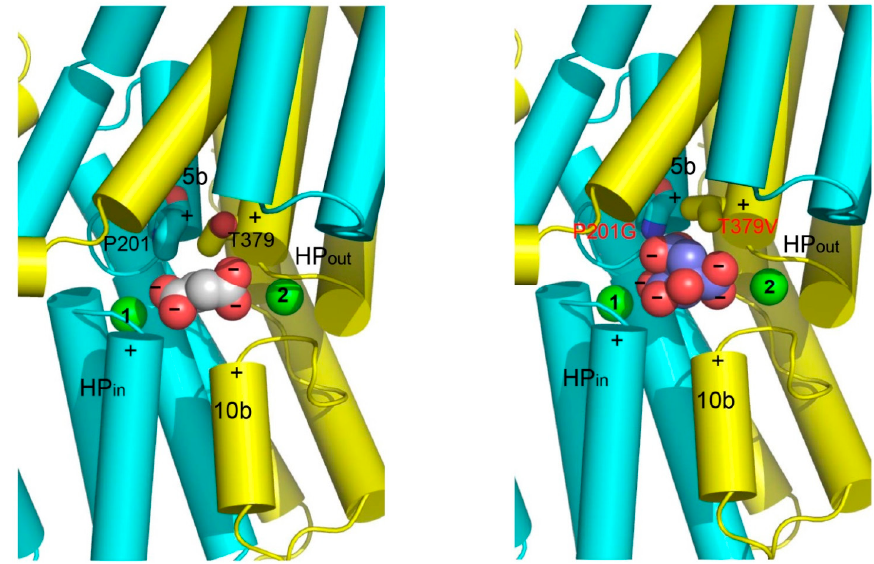
Figure 7. Structural basis for substrate recognition by DASS. The N and C domains in VcINDY ( left panel ) and its humanized variant ( right panel ) are colored cyan and yellow, respectively. Relevant amino acids are drawn as stick models, whereas the bound succinate ( left panel ) or citrate ( right panel ), as well as the Na + ions (green) are shown as spheres. Positive helix dipoles for short helices TM5b and TM10b are highlighted by plus signs, whereas the negatively charged carboxylates in succinate or citrate are indicated by minus signs. The charged state of succinate or citrate is deduced based on the crystallization pH (~7). Both the helix dipoles and Na + appear to contribute to the anion binding. Furthermore, P201 and T379 may enable VcINDY to select for succinate but against citrate. In MT5, P201, and T379 are replaced by Gly and Val, respectively, which may allow the membrane-embedded transporter to bind citrate more strongly than VcINDY.